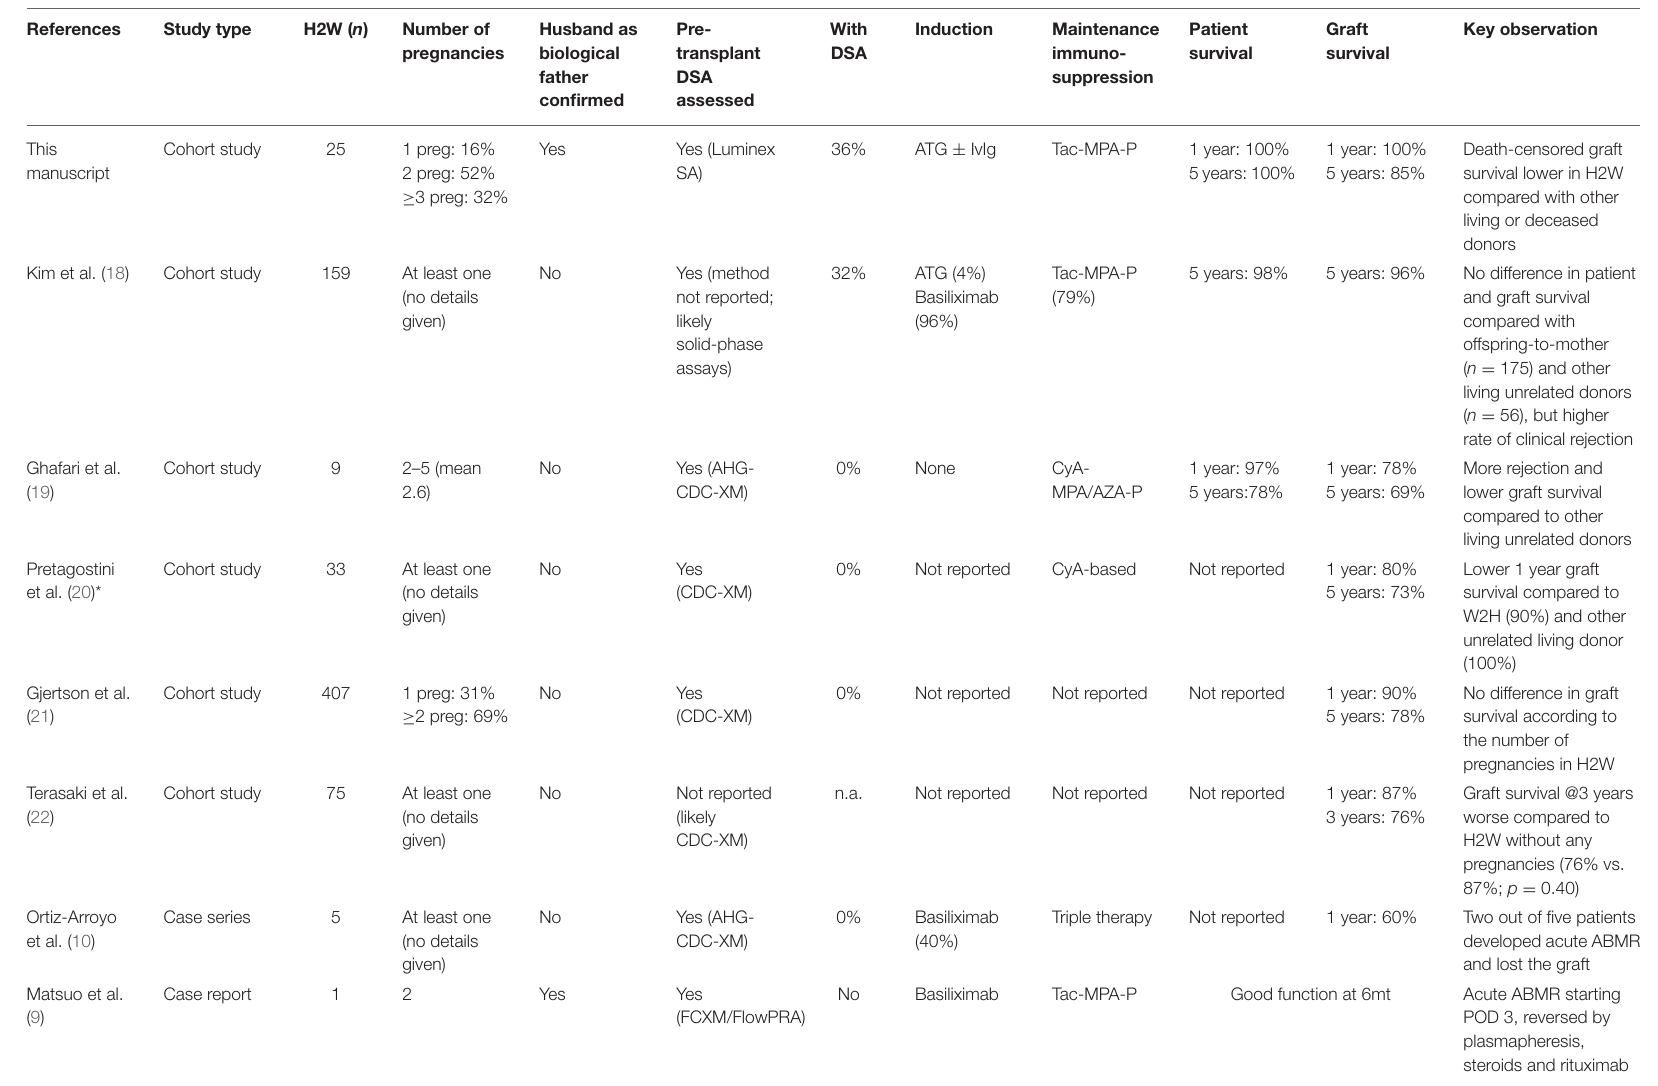
TABLE 4 | Review of the